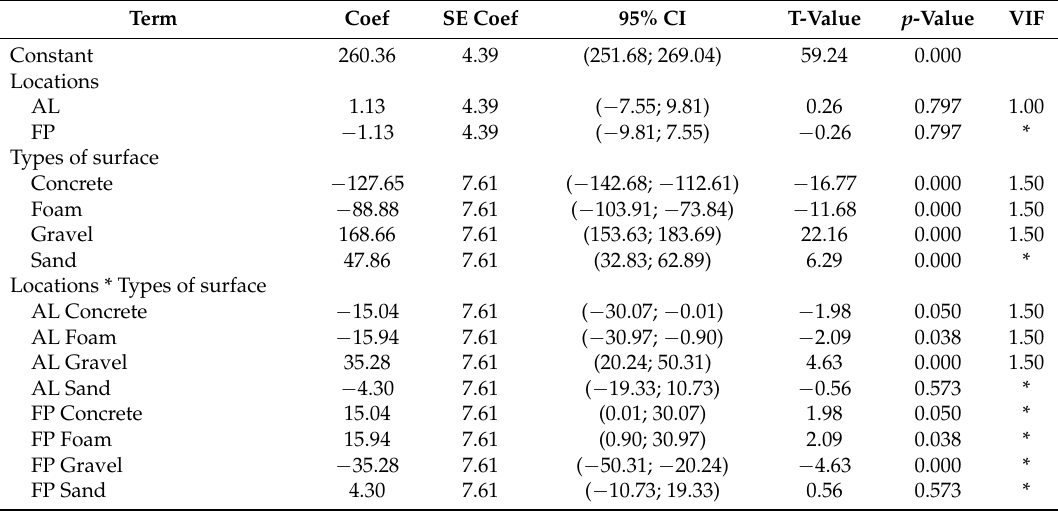
Table 5. Two-way ANOVA coefficient: distance between factor levels and the overall